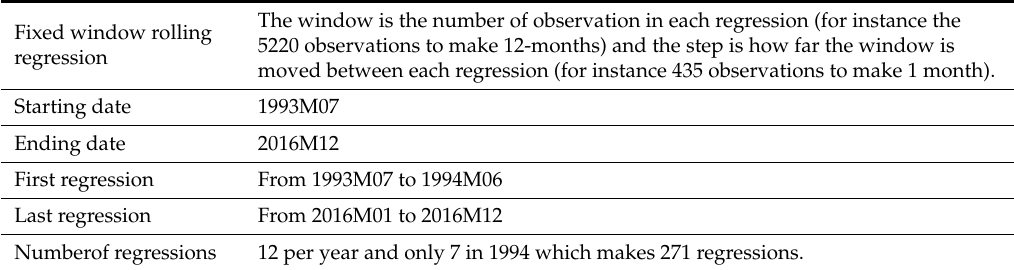
Table 9. Rolling regression parameters. Source: prepared by Authors.